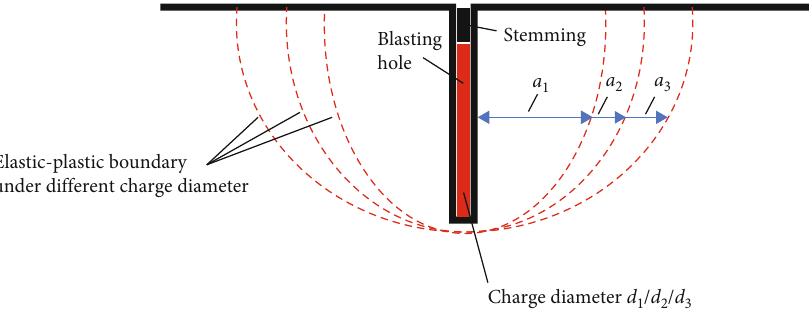
Figure 5: Elastic-plastic boundary under di ff erent charge diameter.